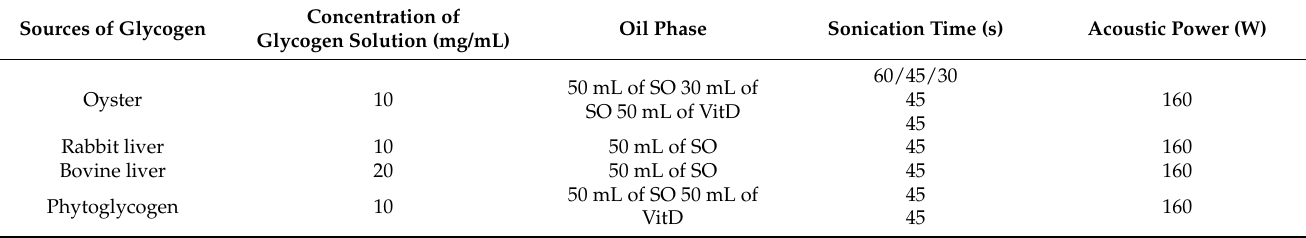
Table 2. Experimental setup for the synthesis of